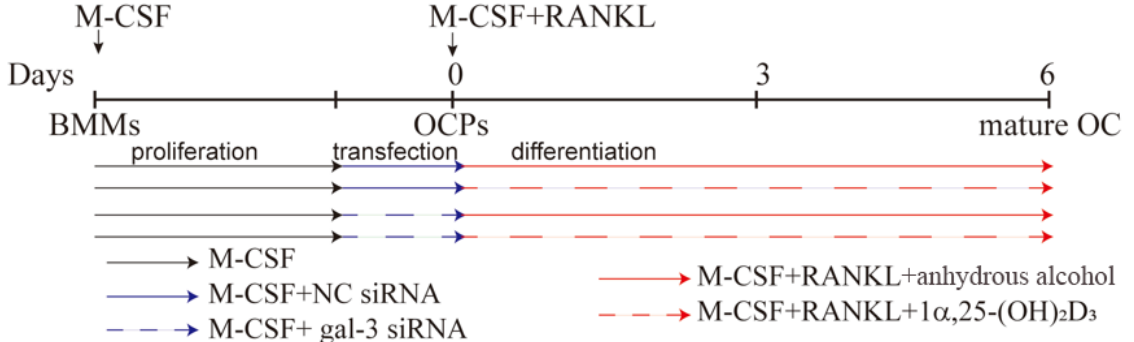
Figure 11. Timeline of cell transfection and the treatment with 1 α ,25-(OH) 2 D 3 . The black solid line represents M-CSF, the blue solid line represents M-CSF+NC siRNA, the blue dashed line represents M-CSF+gal-3 siRNA, the red solid line represents M-CSF+RANKL, and the red dashed line represents M-CSF+RANKL+1 α ,25-(OH) 2 D 3